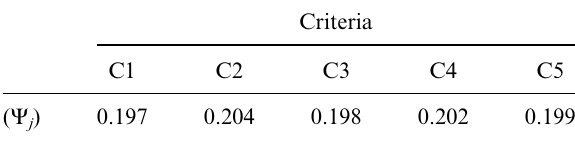
Table 8. The overall preference value